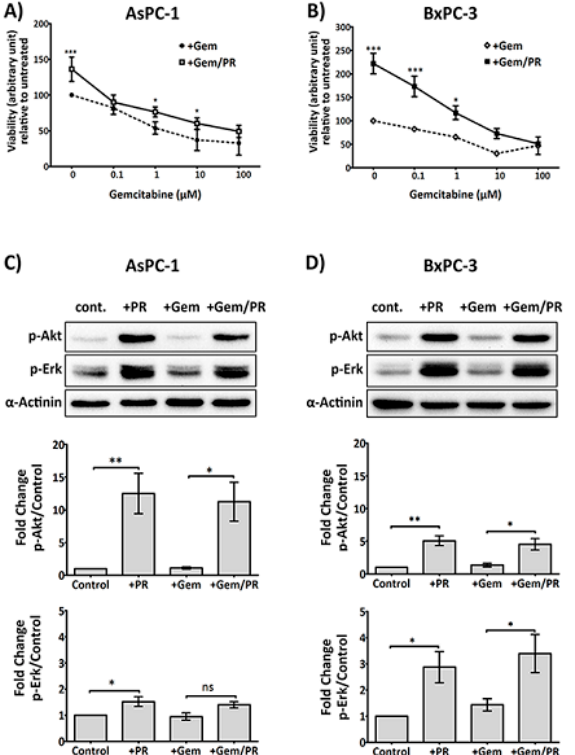
Figure 1. Platelet releasate (PR) promotes pancreatic ductal adenocarcinoma (PDAC) cell survival in the presence of gemcitabine. PDAC cell lines, AsPC-1 ( A ) or BxPC-3 ( B ), were seeded at 5000 cells/well, in a 96-well plate for 24 h, then treated with platelet releasate (PR) ± gemcitabine (0 to 100 µM) for 72 h. PR was prepared from xl-CRP (1 µg/mL)-aggregated platelets (5 × 10 9 platelets/mL) and used in cell culture at 1:10 dilution, resulting in the final concentration equivalent to the amount of releasate from 5 × 10 8 platelets/mL. Cell proliferation was quantified by Alamar blue reagent, a non- toxic cell health indicator dye that is converted to fluorescent red colour in living cells. The fluorescence intensity (ex/em 570 nm/610 nm) was quantified by a multi-mode plate reader (PerkinElmer). Statistics were calculated using two-way ANOVA, with n = 5 for ( A ) and n = 4 for ( B ), *** p < 0.0001, * p < 0.05. Changes in the phosphorylation status of Protein kinase B (Akt) and Extracellular signal-regulated kinase (Erk) in cancer cells at 2 h were determined following high-dose gemcitabine treatment (25 µM for AsPC-1 and 10 µM for BxPC-3). Briefly, cancer cells were seeded at 3 × 10 5 cells/well in a 6-well plate for 24 h, serum starved for 6 h, then treated with PR ± gemcitabine for 2 h. Cell lysates were separated by SDS-PAGE and immunoblotted using phospho-specific antibodies for Akt (upper panel) and Erk1/2 (middle panel). Alpha ( α )-actinin (lower panel) was used as loading controls for each protein. The expression level of the protein of interest was quantified and normalised to the loading control with automated software Image Lab (version 5.1, BioRad, CA, USA) and GraphPad Prism 5 (GraphPad Software, Inc, CA, USA). The columns represent fold changes in protein expression level compared to vehicle control-treated cells. Data are presented as mean ± SEM. One-way ANOVA with post-hoc Bonferroni’s Multiple Comparison Test was used to examine the significance of the mean, with n ≥ 4 for ( C ) and n ≥ 3 for ( D ), ** p < 0.001, * p < 0.05. Abbreviations: Gem—gemcitabine, xl-CRP—cross-linked Collagen-related peptide, PDAC—pancreatic ductal adenocarcinoma, PR—platelet releasate, Akt—Protein kinase B, Erk—Extracellular signal-regulated kinase, SDS-PAGE—sodium dodecyl sulfate polyacrylamide gel electrophoresis, ANOVA—Analysis of